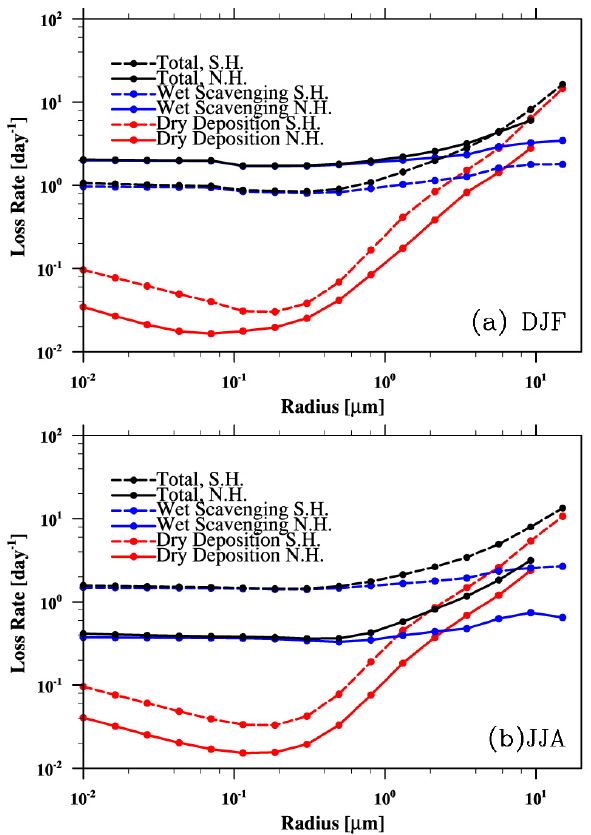
Fig. 21. The dry deposition, wet scavenging and total loss rate of particles as a function of dry radius for 30–60 ◦ N (Northern Hemisphere, N. H.) and 30–60 ◦ S (Southern Hemisphere, S. H.) in (a) June, July, and August (JJA) and (b) December, January, Febru- ary (DJF). The model used a solubility factor of 0.5.